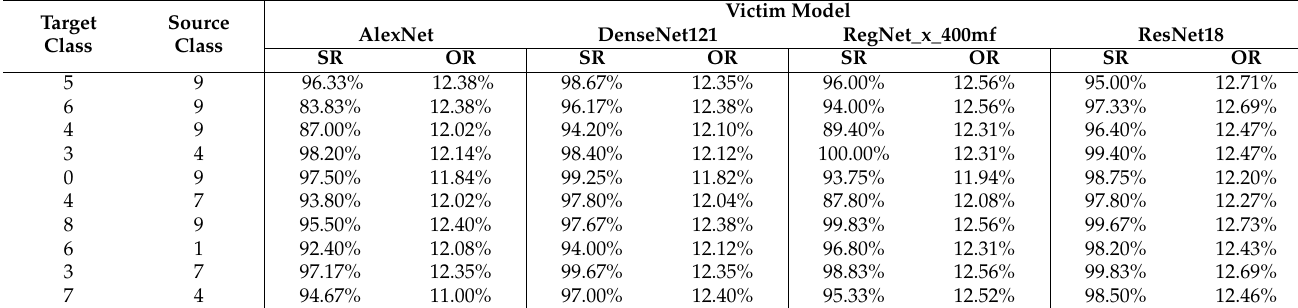
Table 2. TSR of STUAE on EuroSAT with four victim models: AlexNet, DenseNet121, Reg- Net_x_400mf, and ResNet18. The goal of the adversaries is to mislead victim models to recognize images from the source class to the target class . SR (the higher, the better) stands for the ratio of images from the source class to be predicted as the target class, while OR (the lower, the better) stands for the ratio of images from the other classes to be predicted as the target class.